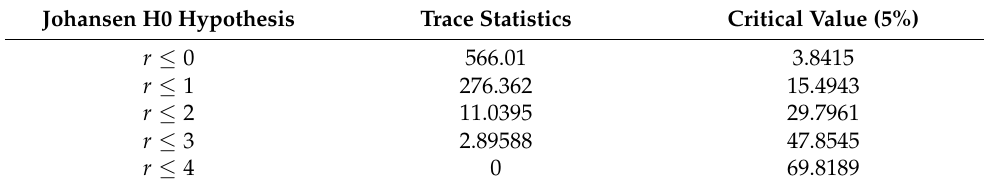
Table 3. Johansen test results without ACE.